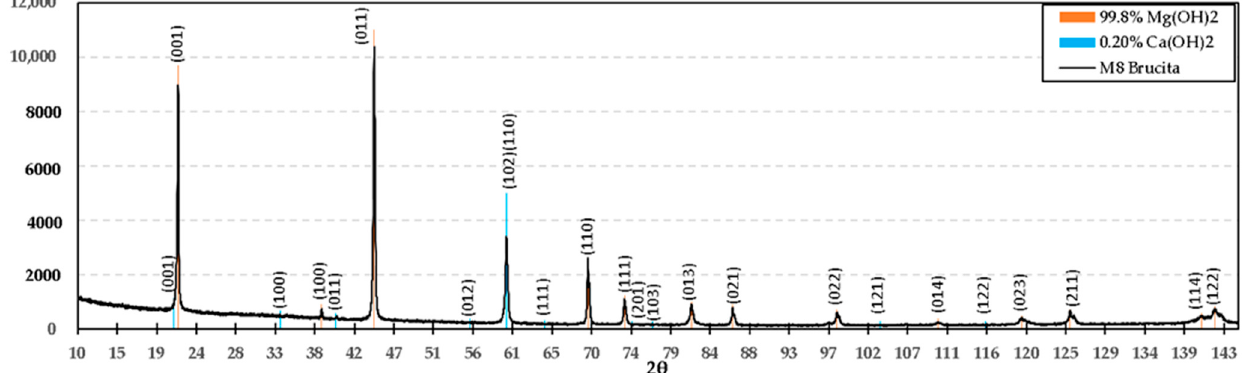
Figure 14. Diffractogram of the M4 formulation (uncalcined brucite).